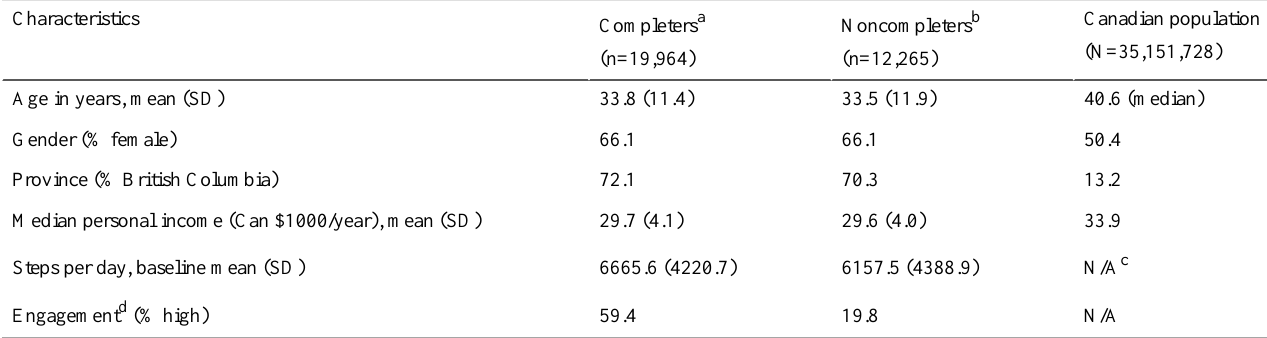
Table 1. Baseline characteristics of Carrot Rewards users, by completion status, and for the general Canadian